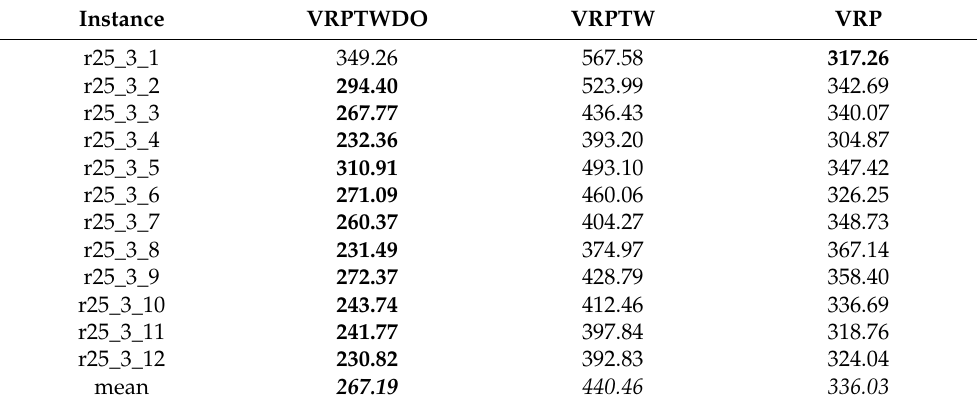
Table 1. Comparison with classical approaches of deliveries (25-customer